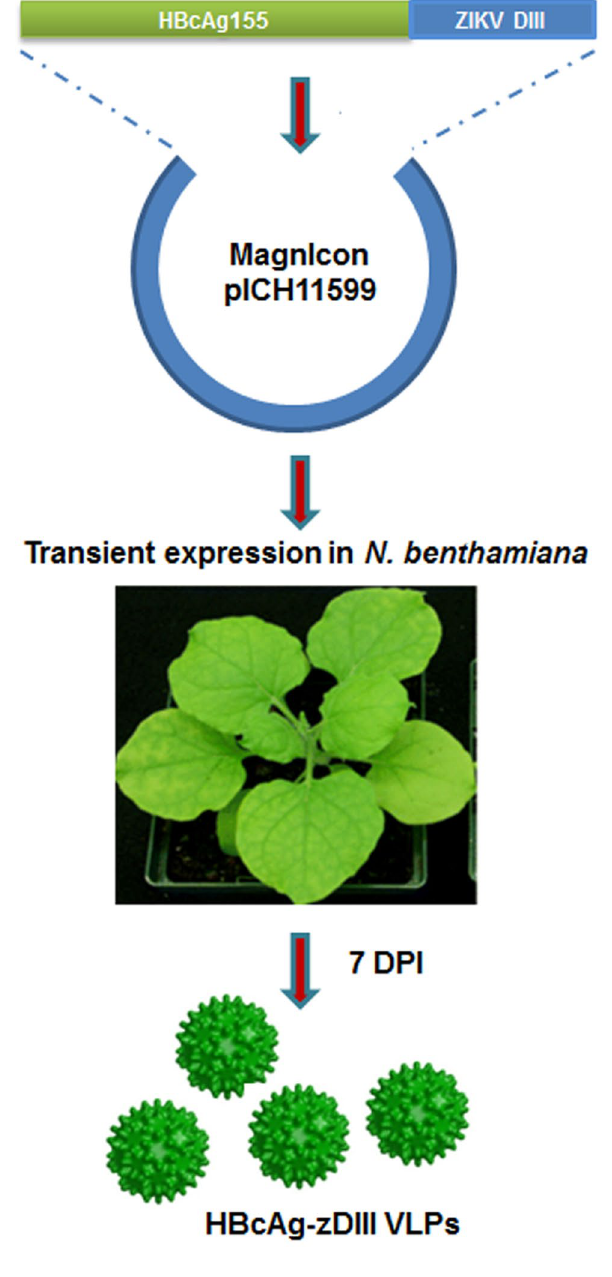
Figure 1. Expression of HBcAg-zDIII in N. benthamiana plants . The coding sequence of zDIII was fused to the 3 ′ end of the coding sequence of HBcAg (amino acid 1 to 155) and cloned into the MagnICON-based plant expression vector pICH11599. The A. tumefaciens strain that contains pICH11599-HBcAg-zDIII construct was agroinfiltrated into N. benthamiana leaves for transient expression. Leaves were harvested at 7 days post agroinfiltration (DPI) for HBcAg-zDIII